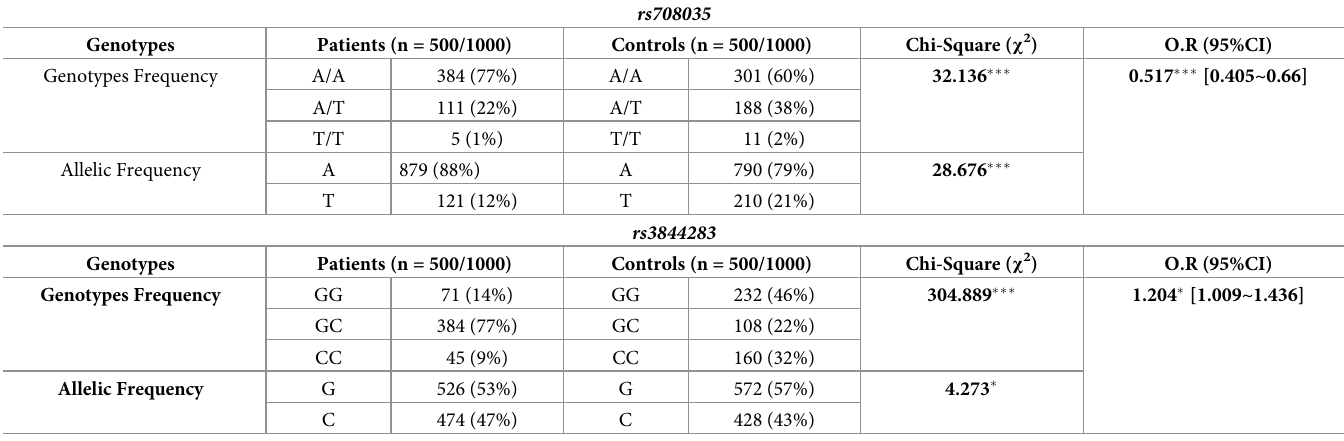
Table 2. Association analyses of SNPs rs708035 and rs3844283 .